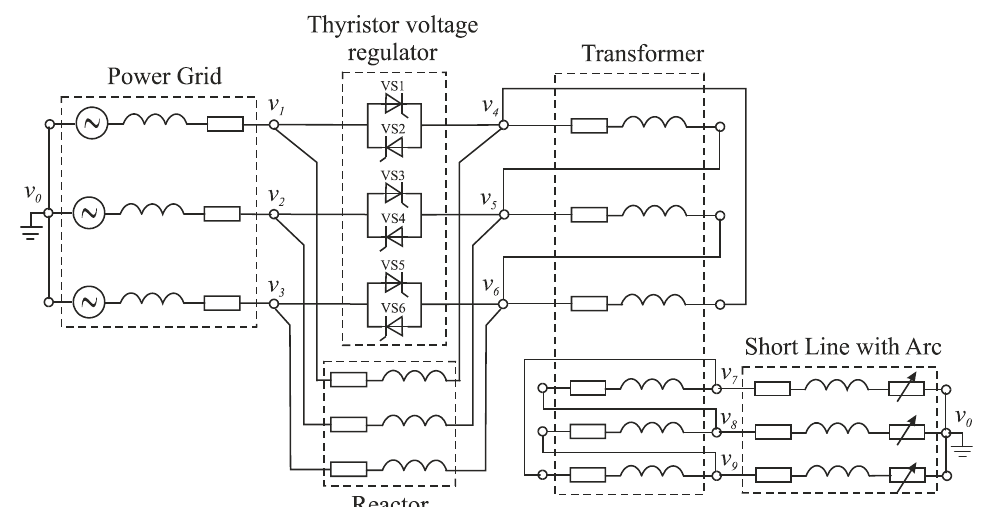
Figure 1. Calculation scheme of the system “arc steelmaking furnace—power supply system”. The scheme is formed by connecting the outer circuits of multipole elements, namely: According to the calculation scheme in Figure 1, these matrices will appear three-phase network, controlled reactor (represented by a combination of thyristor voltage regulator and three-phase inductor), transformer and three-phase short circuit with an arc. The outer circuits of these multipolar elements are interconnected at the nodes of the system. The potentials of the independent nodes of the system are denoted as ν 1 – ν 9 . According to the theory of multipoles, the method of connecting a multipole element is described by an incidence matrix containing 0 and 1 and indicating which independent node in the system is connected to the pole of the element. Let us denote the incident matrices: Π N (three phases power supply), Π TVR (thyristor voltage regulator), Π r (three- phase choke), Π TR (transformer) and т a Π SL (three-phase short connection with an arc). Such matrices will be used for equations on electrical potential in system nodes.